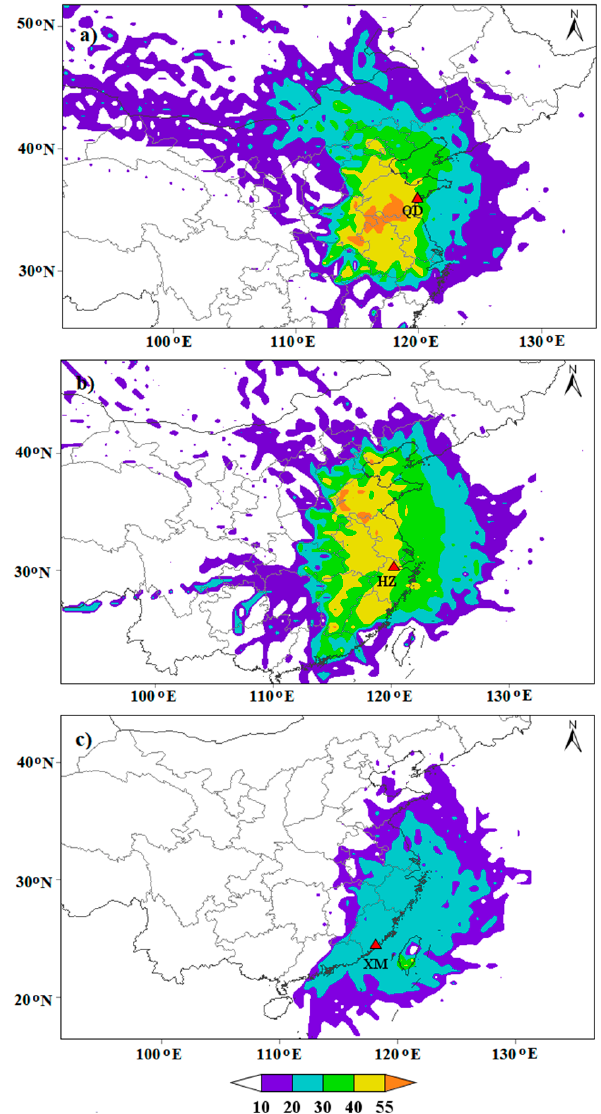
Figure 10. Concentration-weighted trajectory (CWT) maps for PM 2.5 in Qingdao ( a ), Hangzhou ( b ), and Xiamen ( c ) during 2018. The red solid triangle denotes the center of the studied city, and the CWT values are displayed in color.